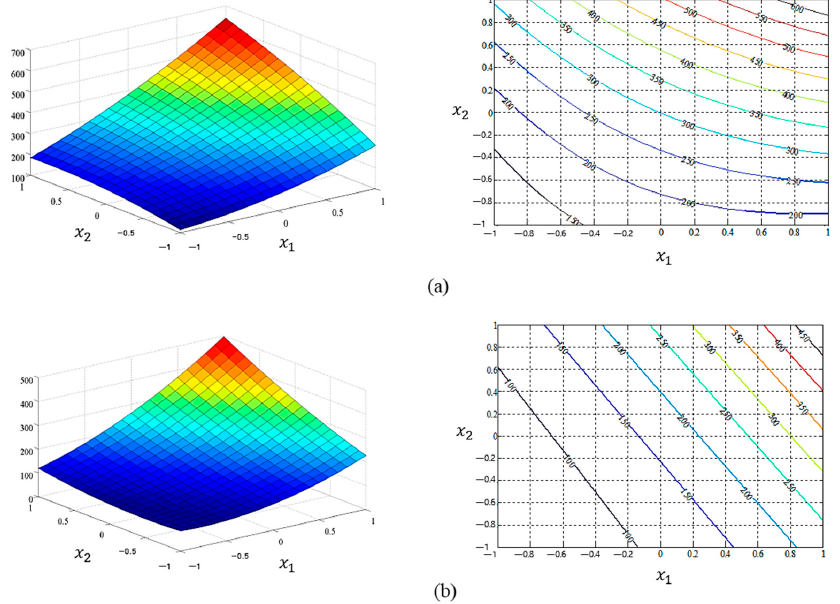
Figure 4. Graphical representation of the estimated mean response functions between x 1 and x 2 : ( a ) the response surface plot and response function of LSM ( R 2 = 92.68% and RMSE = 60.40); ( b ) the response surface plot and response function of NN ( R 2 = 86.37% and RMSE = 82.47).